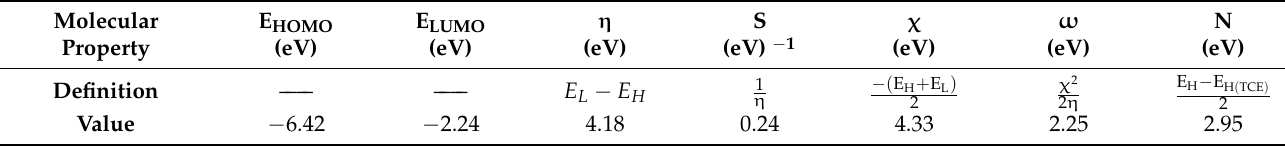
Table 3. Calculated quantum chemical parameters for the studied molecule; HOMO & LUMO energies, chemical hardness, chemical softness, electronegativity, and electrophilicity